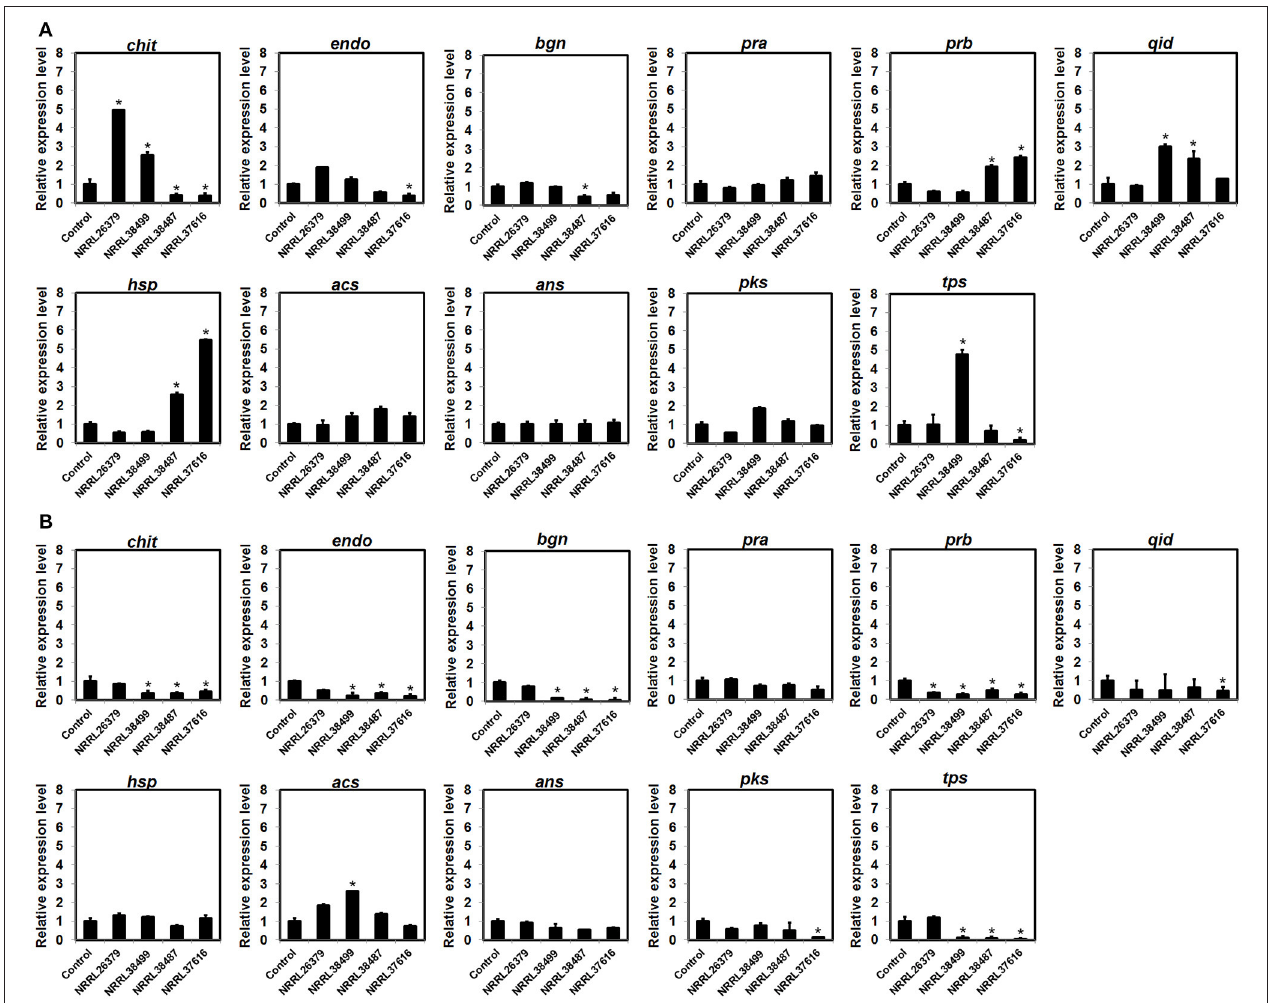
FIGURE 7 | Expression patterns of biocontrol-associated genes after exposure to F. oxysporum VCs. Transcripts from 11 genes in (A) T. virens strain G-41 and (B) T. harzianum strain T-22 were quantified after co-cultivation with four F. oxysporum strains (NRRL26379, NRRL38499, NRRL38487, and NRRL37616) for 40h and 33h, respectively. Transcripts from the elongation factor 1- α and β -actin genes were used as internal references to normalize the level of transcripts for individual genes. Control corresponded to Trichoderma co-cultivated with un-inoculated PDA. Values shown correspond to the relative expression replicates. Gene identity based on the abbreviation scheme shown in Table 2 is indicated. * indicates up-regulation (relative expression level > 2) or down-regulation (relative expression level <